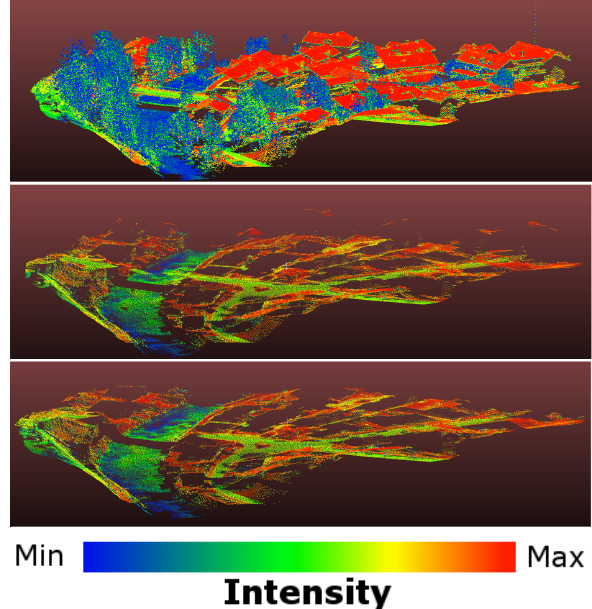
Figure 9. Results of the ground detection. Top: raw data, middle: result of our approach, bottom: ground